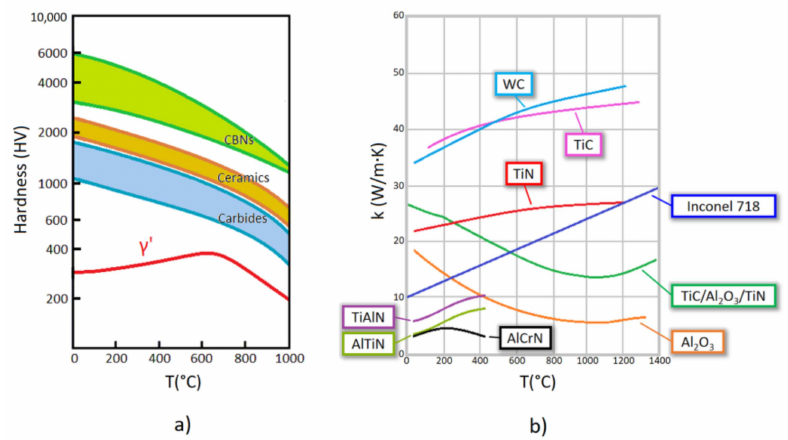
Figure 15. ( a ) Hot hardness characteristic curve of CBN, Ceramic and Carbide tool materials com- pared with the γ (cid:48) structure of INCONEL ® 718, ( b ) Thermal conductivity of tungsten carbide (WC), INCONEL ® 718 and different coatings for carbide tools against T (adapted from